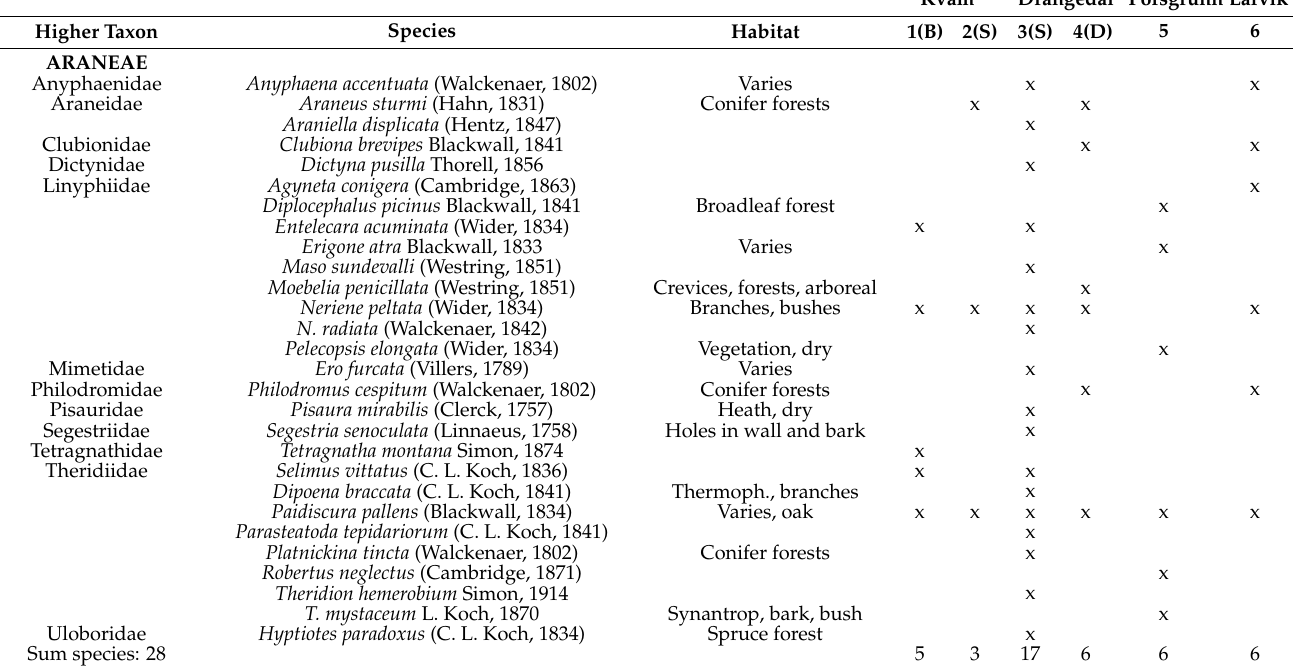
Table A1. Completelistofspecieswithnumbersperlocality. Literatureusedforthetable: [2,6,10,12,27,38,58–60,62–64,67–71,78,87,91–164], relevant volumes of Die Käfer Mitteleuropas, Danmarks Fauna, Svensk Insektfauna, Fauna Entomologica Scandinavica, and personal comments from the authors. The (B) and (S) in the heading under Kvam are Berge and Skeianeset, respectively, while the (S) and (D) under Drangedal are Steinknapp and Djupedal, respectively. An ¤, * or ** in front of the species name depicts a new record for either science, Norway or Nordic countries upon sampling, respectively. x, xx and xxx represent dummy numbers 5, 10 and 20,